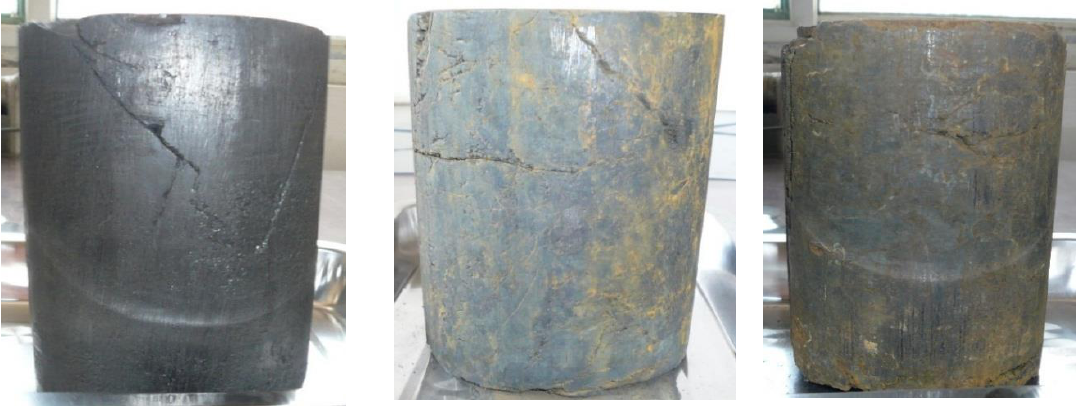
Figure 2. The lumpy coal experimental samples used in this study (from left to right are 1-1, 1-2, and 2-1, respectively).